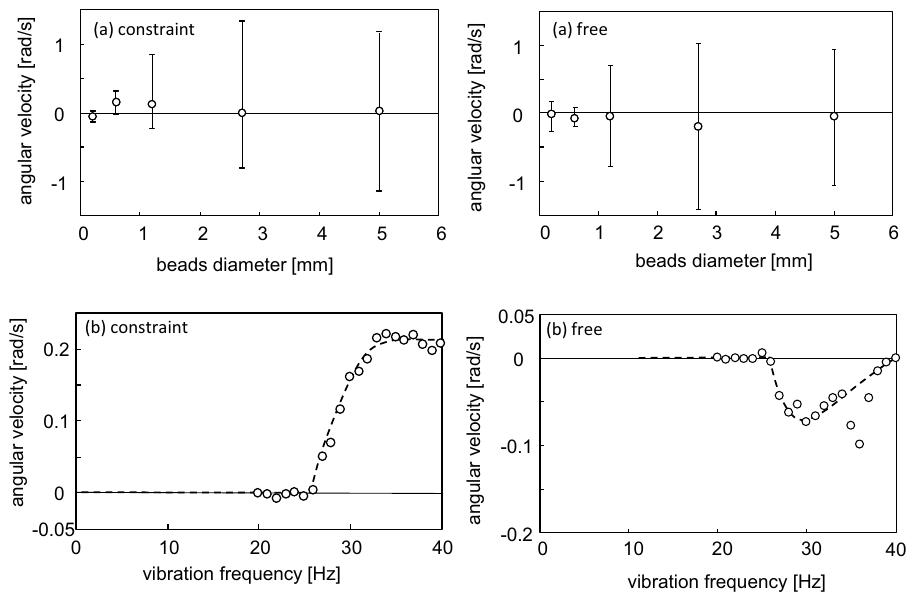
Figure 4. Angular velocities of constraint and free conditions shown as a function of ( a ) bead diameter (for frequency = 30 Hz) and as a function of ( b ) vibration frequency (for bead diameter = 0.6